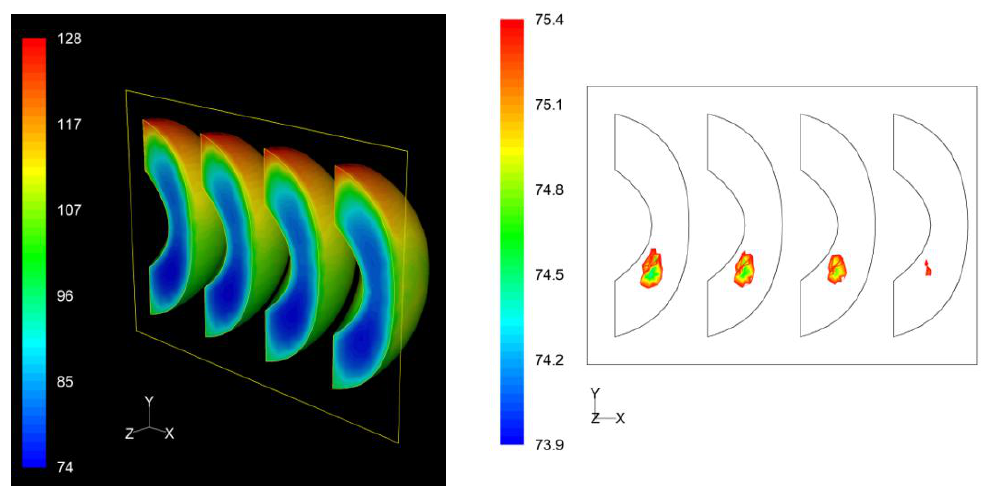
Figure 11. F value (in min) distribution within the peach halves (left) and location of the critical point (right) at the end of the thermal process for the “sideward”